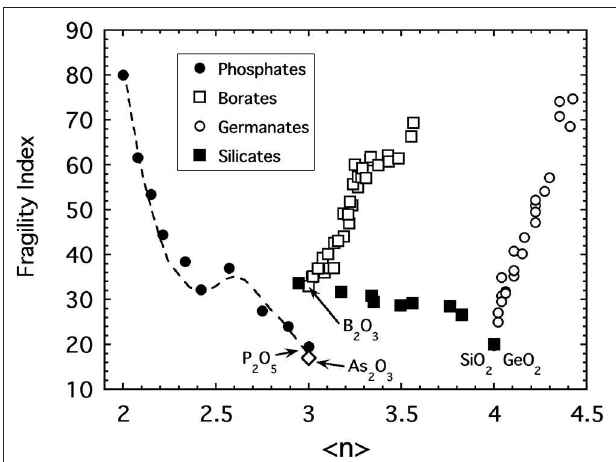
FIGURE 5 | A compilation of fragility indices of various alkali oxide glasses including sodium phosphates (Fabian and Sidebottom, 2009), lithium and sodium borates (Nemilov, 1966; Chryssikos et al., 1994) sodium, potassium and rubidium germanates ( Nemilov, 1970; Shelby, 1974), sodium and potassium silicates ( Poole, 1949) and arsenic trioxide (Yannopoulos et al., 1999; Sidebottom et al., 2007) as a function of the average bridging oxygen per network-forming